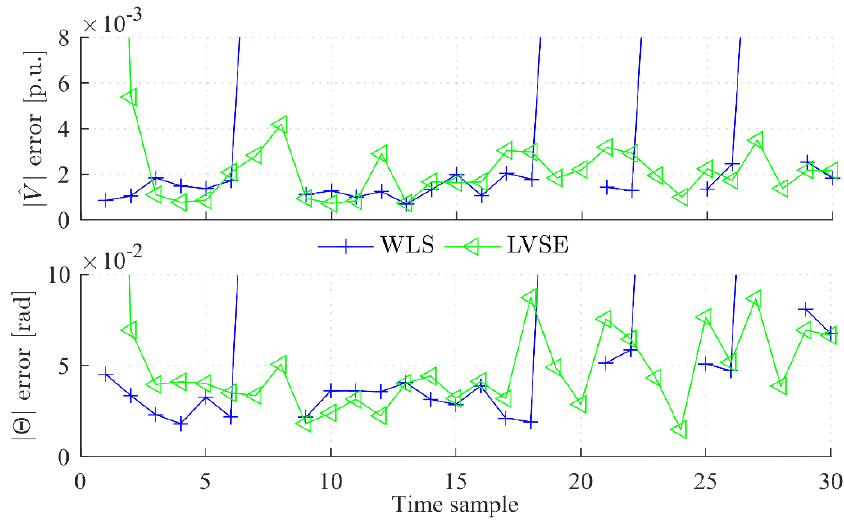
Figure 9. Estimation error — case 3.